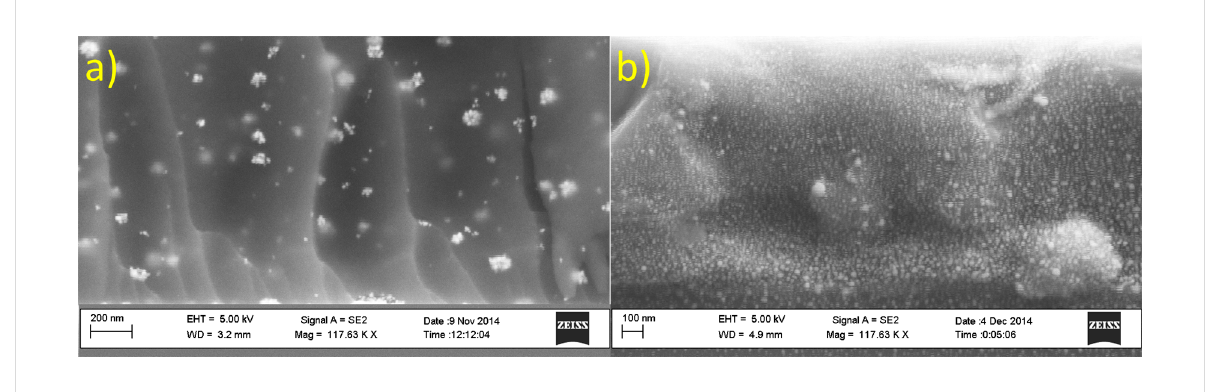
Figure 4: SEM images of a cross section of a nanocomposite on a silicon wafer containing 0.5 mL of 125 mg·mL − 1 AgNO 3 precursor solution. a) after a post-bake at 95 °C for 10 min and b) after an additional bake at 300 °C for 30 min.